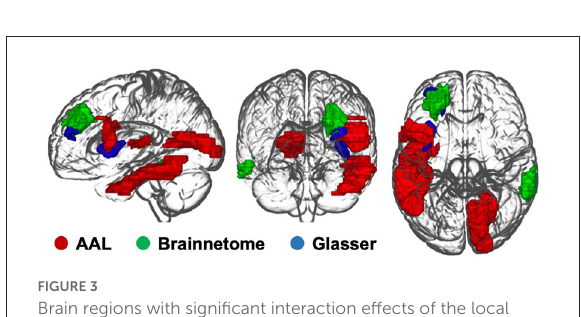
FIGURE3 Brain regions with significant interaction effects of the local network